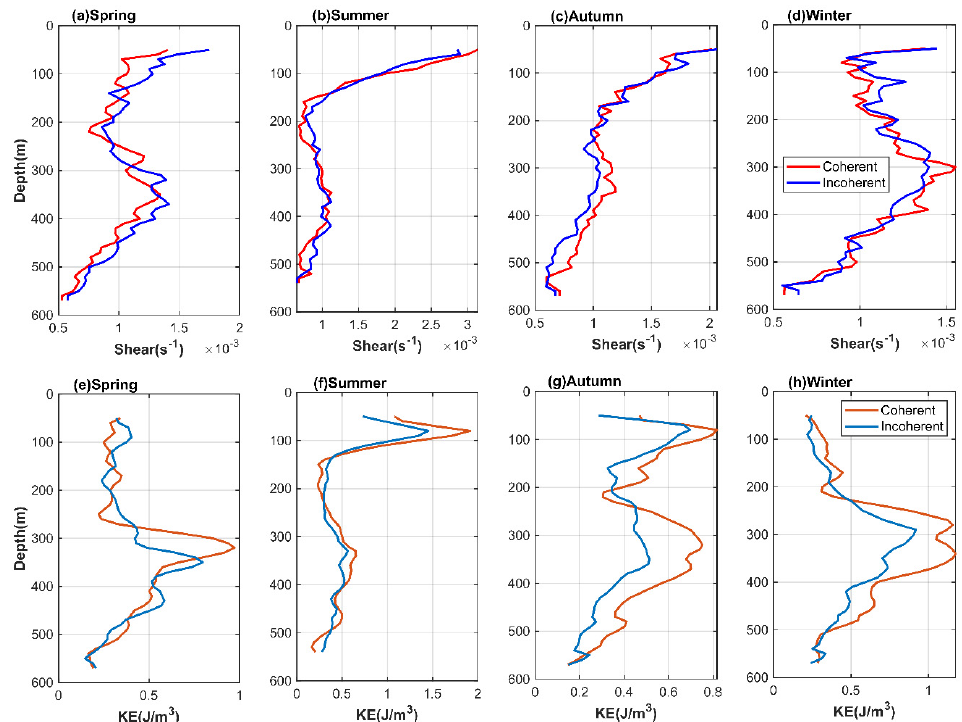
Figure 12. Vertical structures of the seasonal mean shear and kinetic energy densities of the coherent and incoherent components of D3 ITs. ( a – d ) indicate the shear in spring, summer, autumn, and winter, respectively, and ( e – h ) denote the kinetic energy densities in spring, summer, autumn, and winter, respectively. Table 4. Time–depth averaged shear and kinetic energy densities of the coherent and incoherent components of D1, D2, and D3 ITs in four seasons.